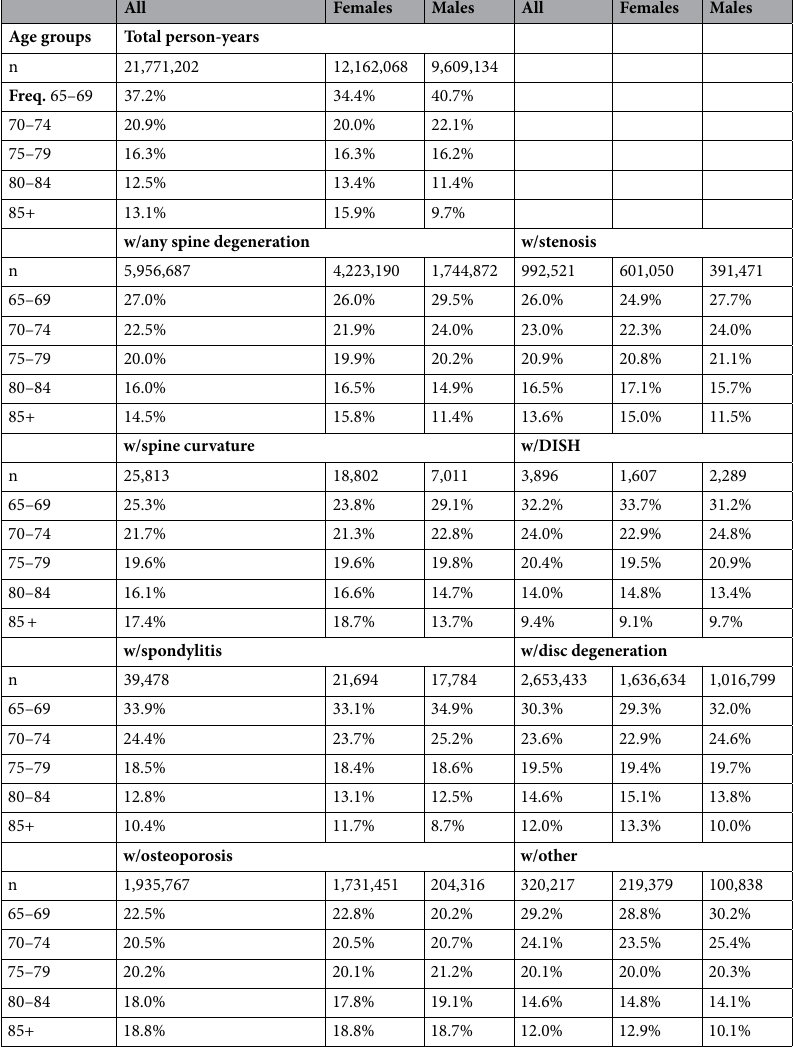
Table 1. Cumulative number and frequency of enrollees in person-years by spine degeneration type, age group, and